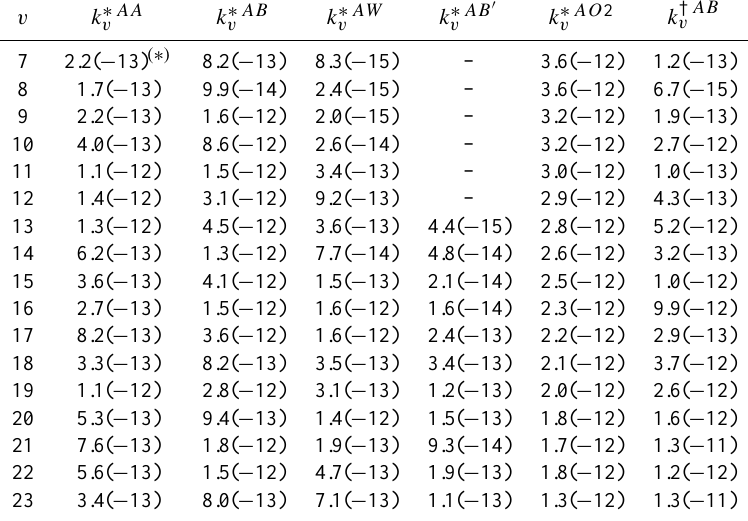
Table 1. Applied rate coefficients in Eq. (8a).